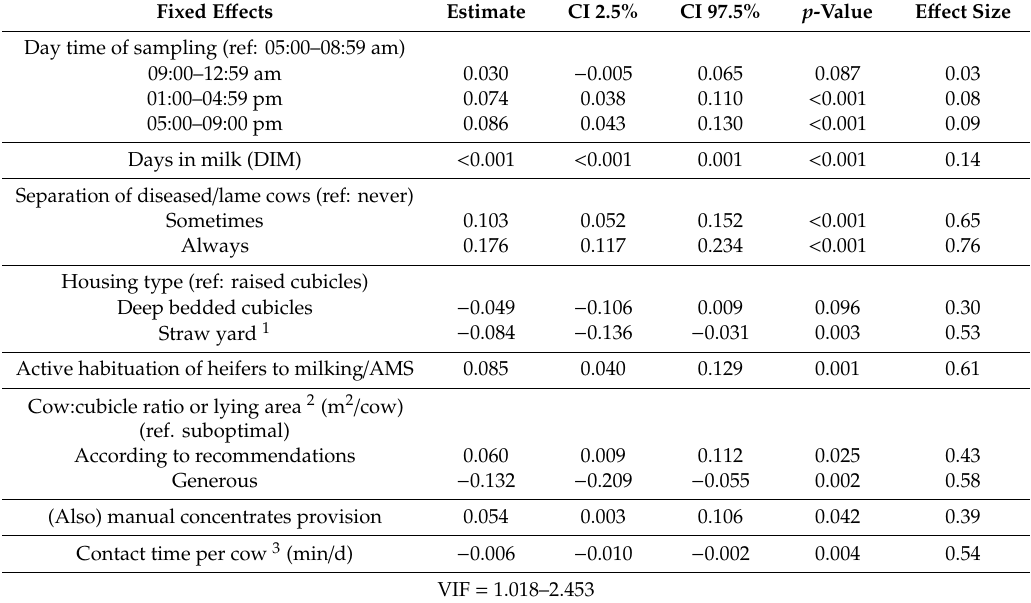
Table 3. Final linear mixed model regarding FCMs (ng / g; data transformed by xˆ0.2); fit by maximum likelihood, random e ff ect: animal nested in farm; number of samples: 2625; number of groups: animals = 674, farms =